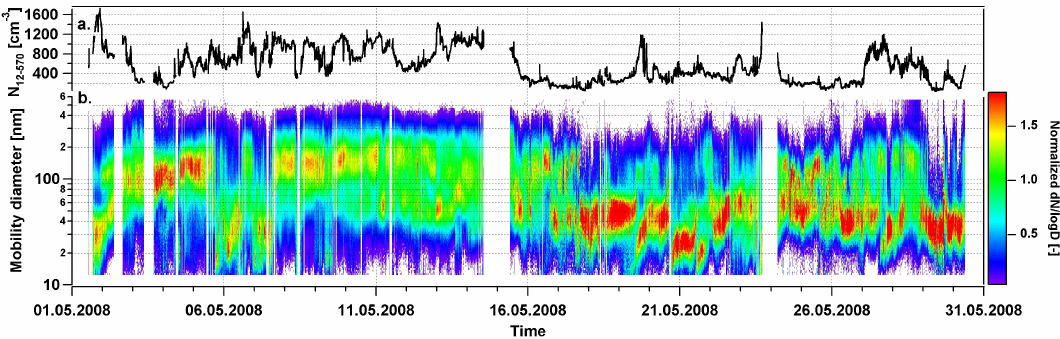
Fig. 2. Size distribution and the integrated number concentration during the measurement campaign. The size distribution was measured by the SMPS between 12nm and 570nm mobility diameter and normalized with the integrated number